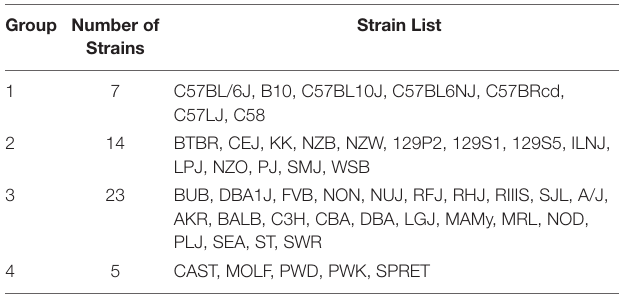
TABLE 1 | The 49 inbred strains can be divided into the four groups shown in this table based on their pattern of genome-wide allelic sharing. Group Number of Strains